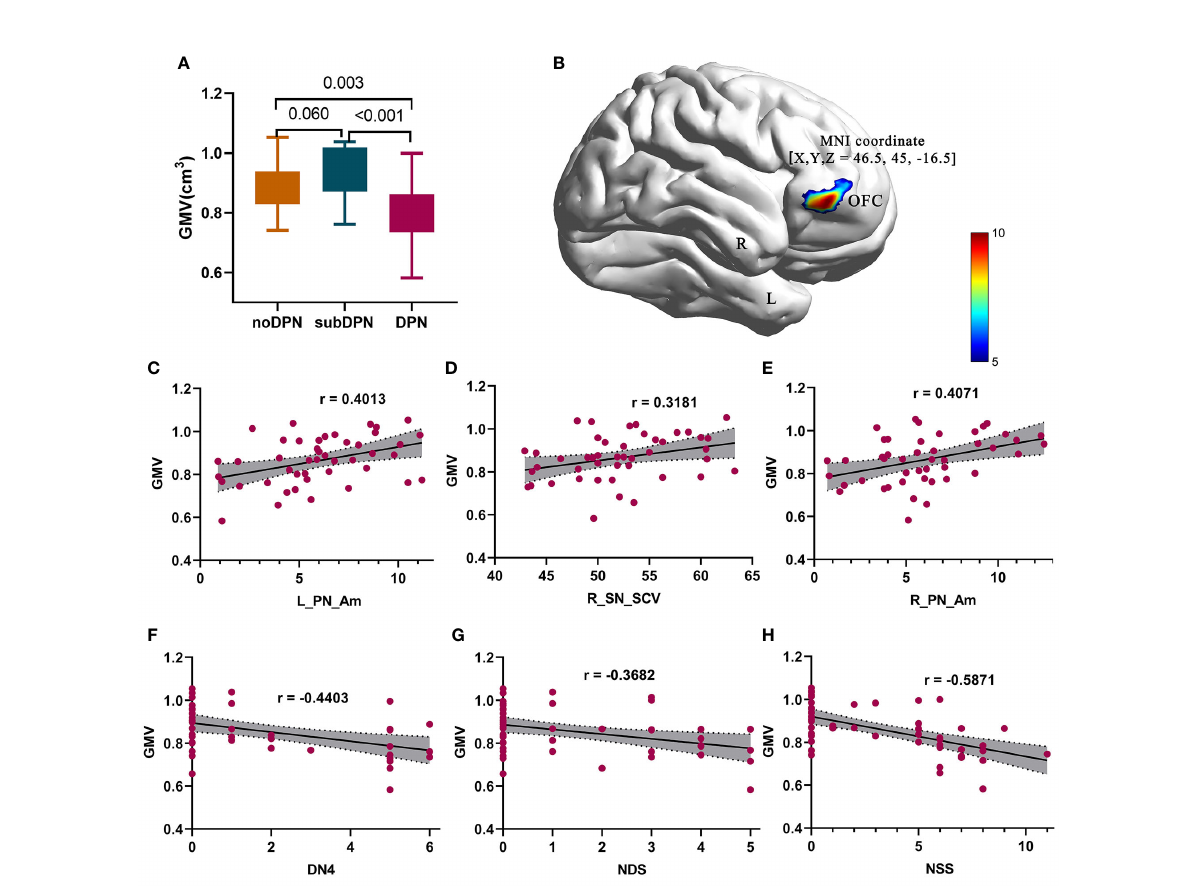
FIGURE 2 Gray matter volume difference presentation and related correlations results. (A) post-hoc results of regional gray matter volume in a bar graph. (B) signi fi cant difference of brain regions within the orbitofrontal cortex. (C – E) positive correlations of GMV with L_PN_Am (C) , R_SN_SCV (D) , and R_PN_Am (E) were shown in points and lines. (F-H) negative correlations of GMV with DN4 (F) , NDS (G) , and NSS (H) were shown in points and lines. The color bar denotes the corresponding T-values. DPN, type 2 diabetic polyneuropathy; subDPN, subclinical type 2 diabetic polyneuropathy; noDPN,type 2 diabetes without polyneuropathy; GMV, gray matter volume; OFC, the orbitofrontal cortex; L, left; R, right; NSS, the Neuropathy Symptom Score; DN4, Douleur Neuropathique en 4 questions; NDS, Neuropathy Disability Score; SCV, sensory nerve conduction velocities. Am, amplitude; PN, the common peroneal nerve; SN, sural